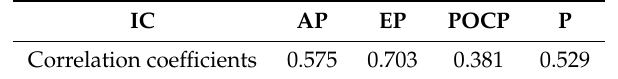
Table 3. Correlation of GWP with Emission ICs.